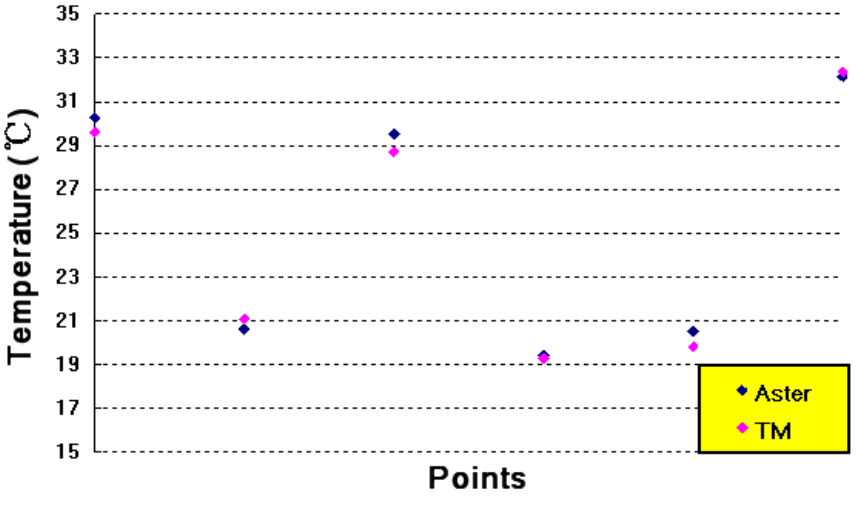
Figure 6. The retrieved LST variation curve of six representative